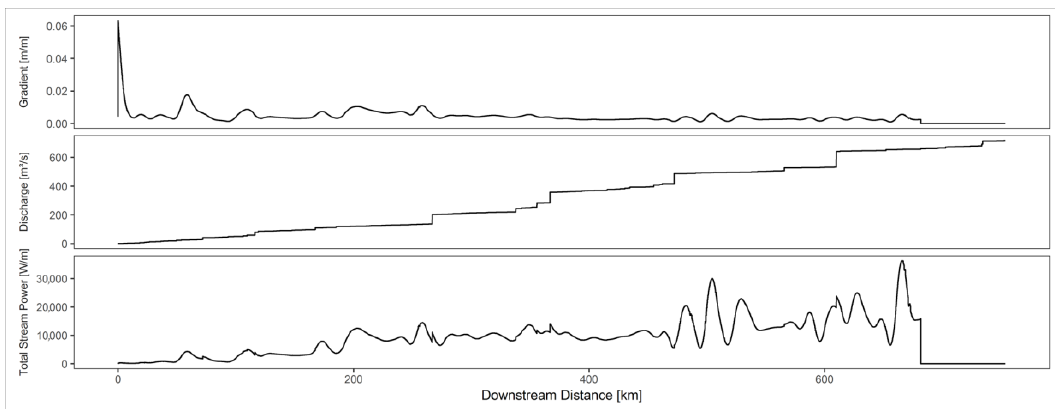
Figure 5. Channel gradients, discharge interpolation and total stream power along the longitudinal profile; the steps in the discharge curve arise from tributaries flowing into the Naryn River and causing a sudden increase in the